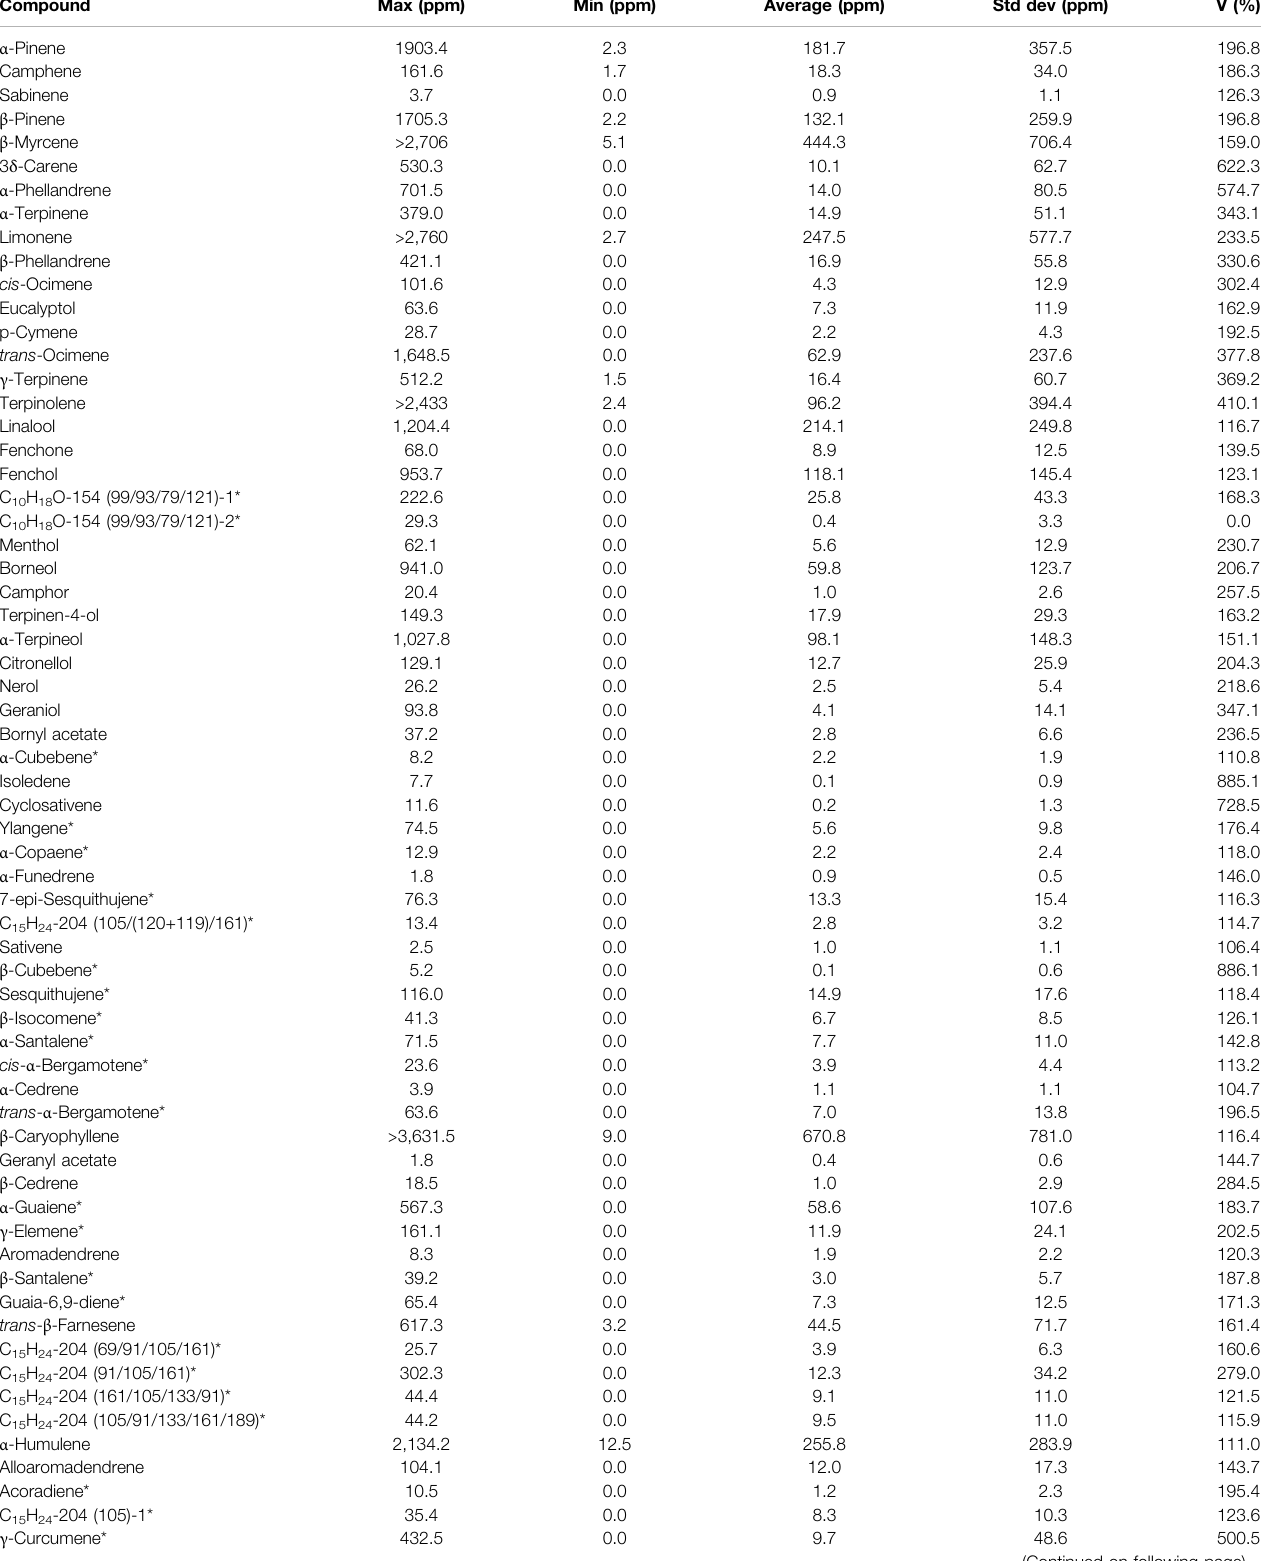
TABLE 2 | Variability of terpenoids in 79 different cultivars.